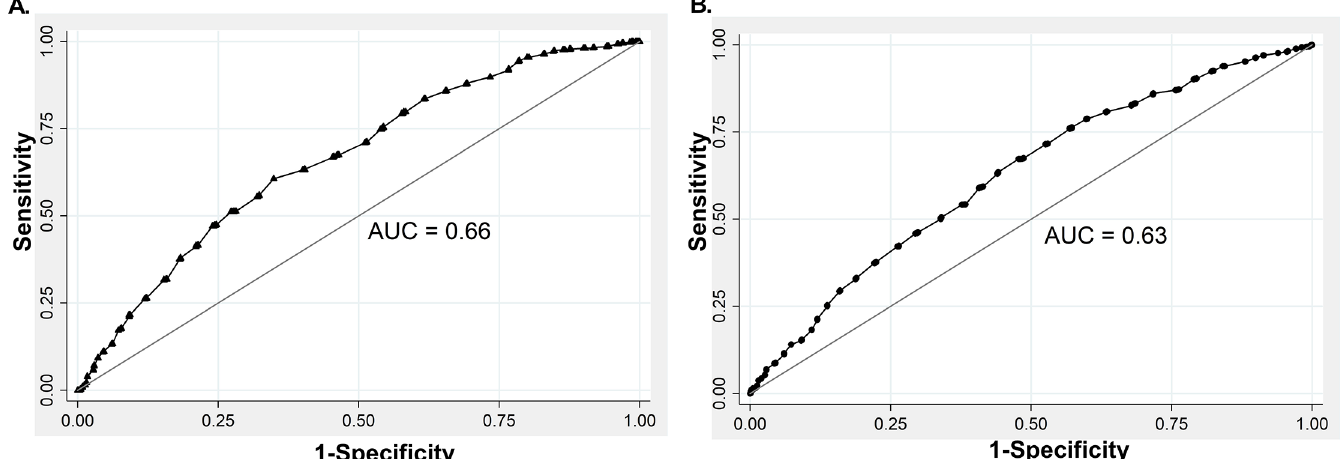
Fig 2. ROC analysis for WC and CVRF in normal and overweight subsample defined by the presence of at least one of the following risk factors: Systolic or diastolic hypertension, total hypercholesterolemia, LDL hypercholesterolemia, decreased HDL-C hypertriglyceridemia, impaired fasting glucose or diabetes mellitus in men (A) and women (B).